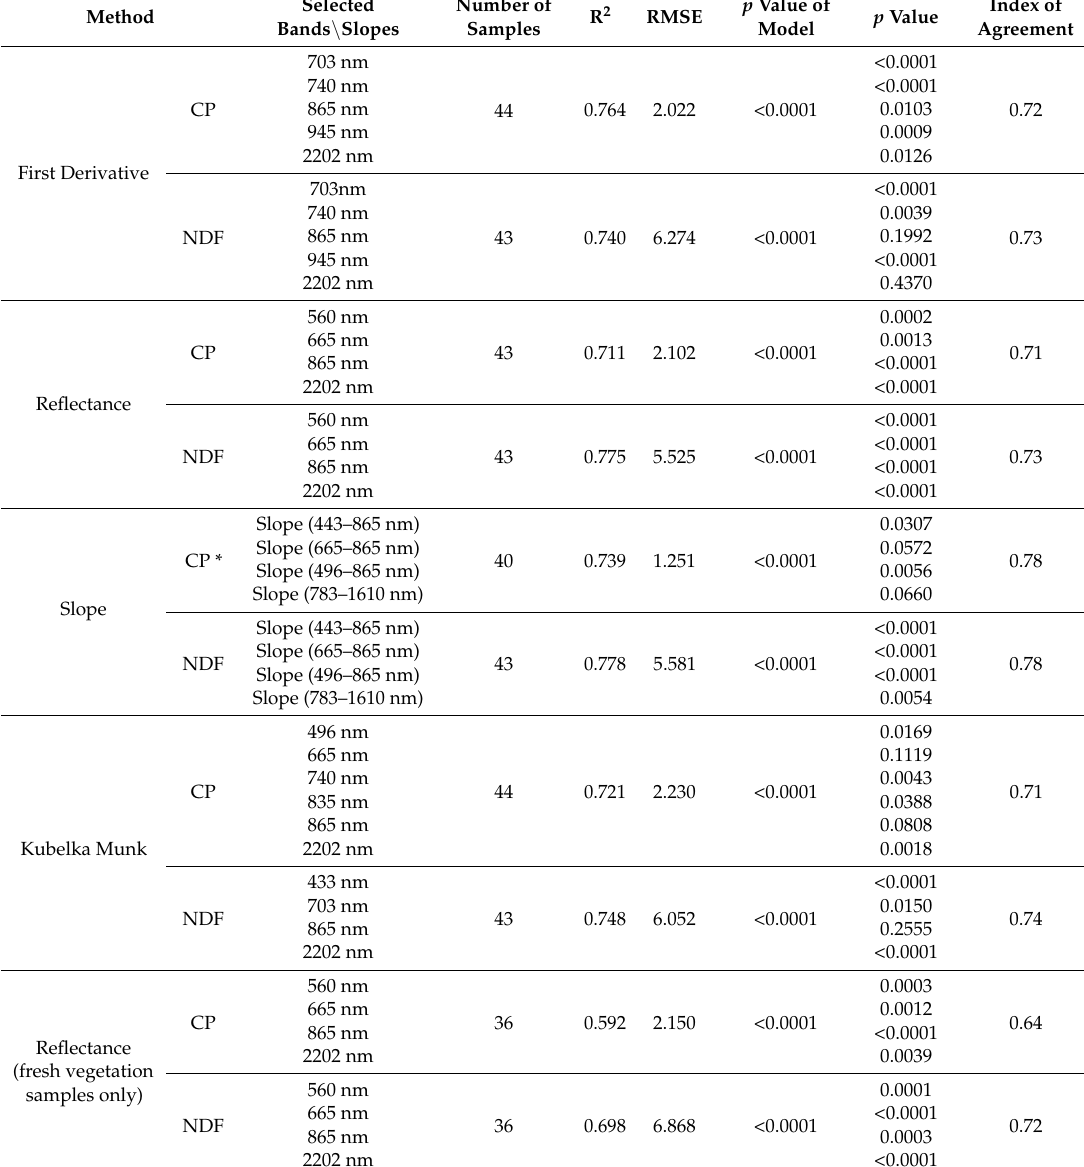
Table 1. Partial least-squares (PLS) regression model results for the reflectance and slope methods, and for various data pre-processing techniques for the estimation of CP and NDF in fresh vegetation. p Value of Index of Selected Number of p Value Method R 2 RMSE Model Bands \ Slopes Samples